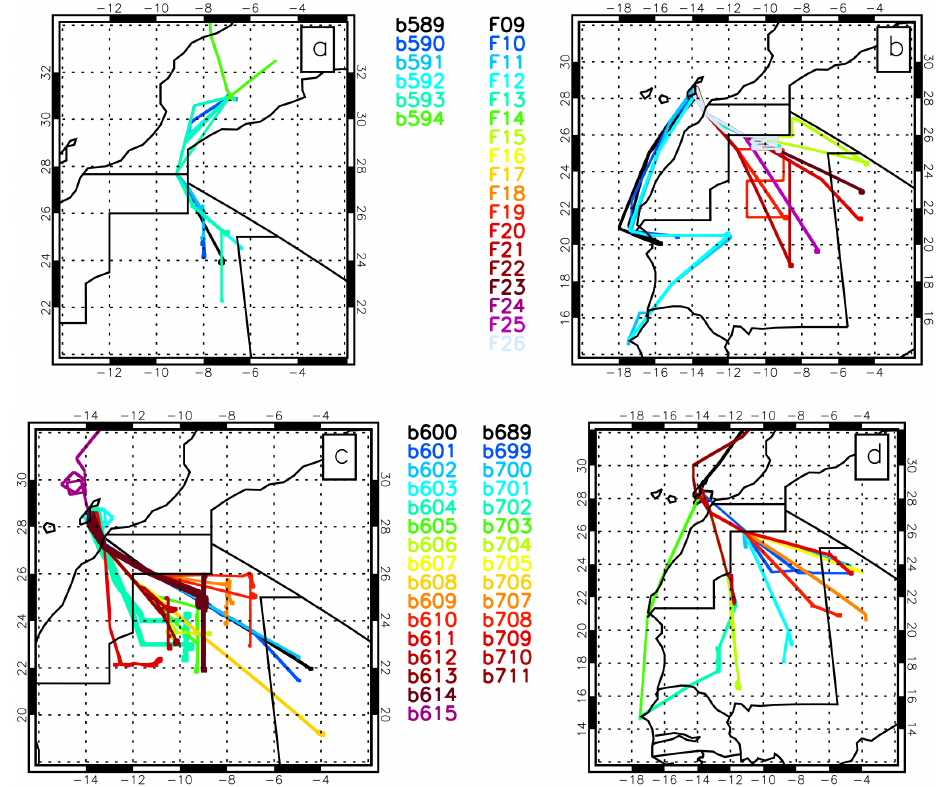
Figure 2. Flight tracks of the BAe146 and Falcon during Fennec: (a) Fennec Pilot, April 2011, BAe146; (b) June 2011, Falcon, (c) June 2011, BAe146, (d) June 2011, BAe146. Each colour shows a different flight. Note that in (b) and (d) , the tracks of the following flights are the same and therefore not visible: F11, F12 and F26; F13 and F18; F14, F16, F17 and F19; F22 and F23; F24 and F25; b706 and